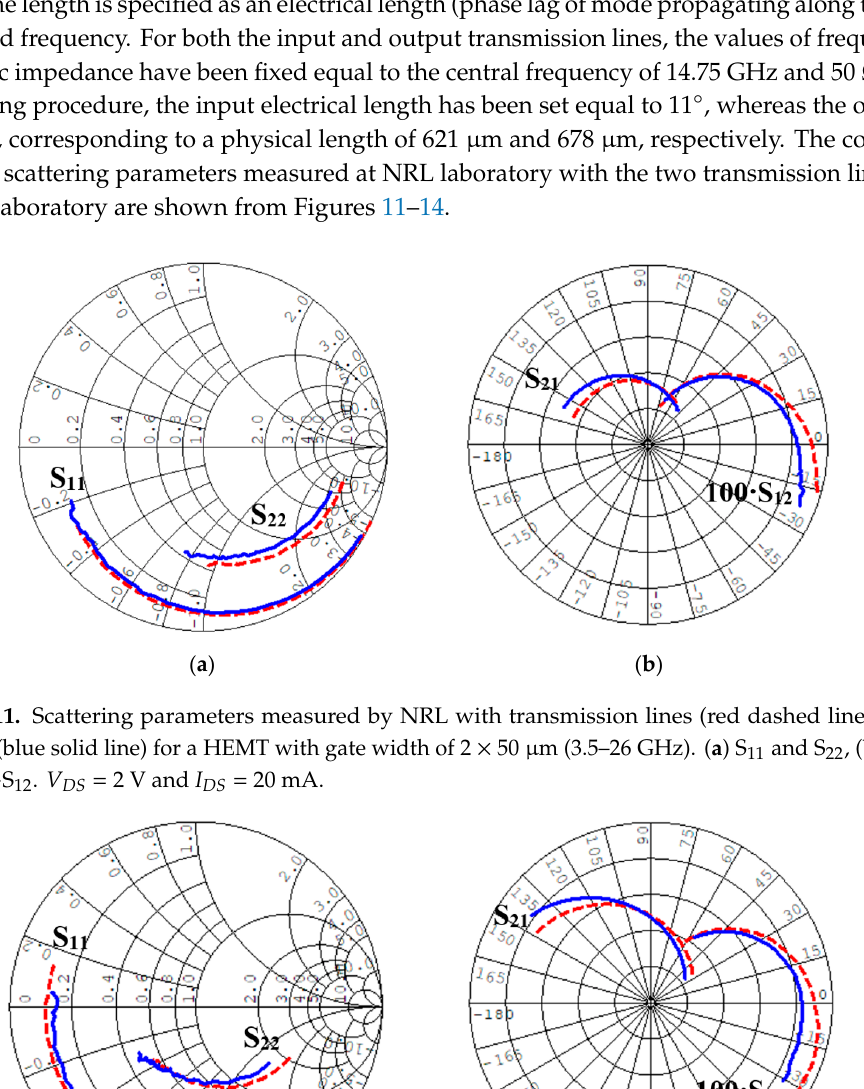
. Figure 10. Schematic of the 2